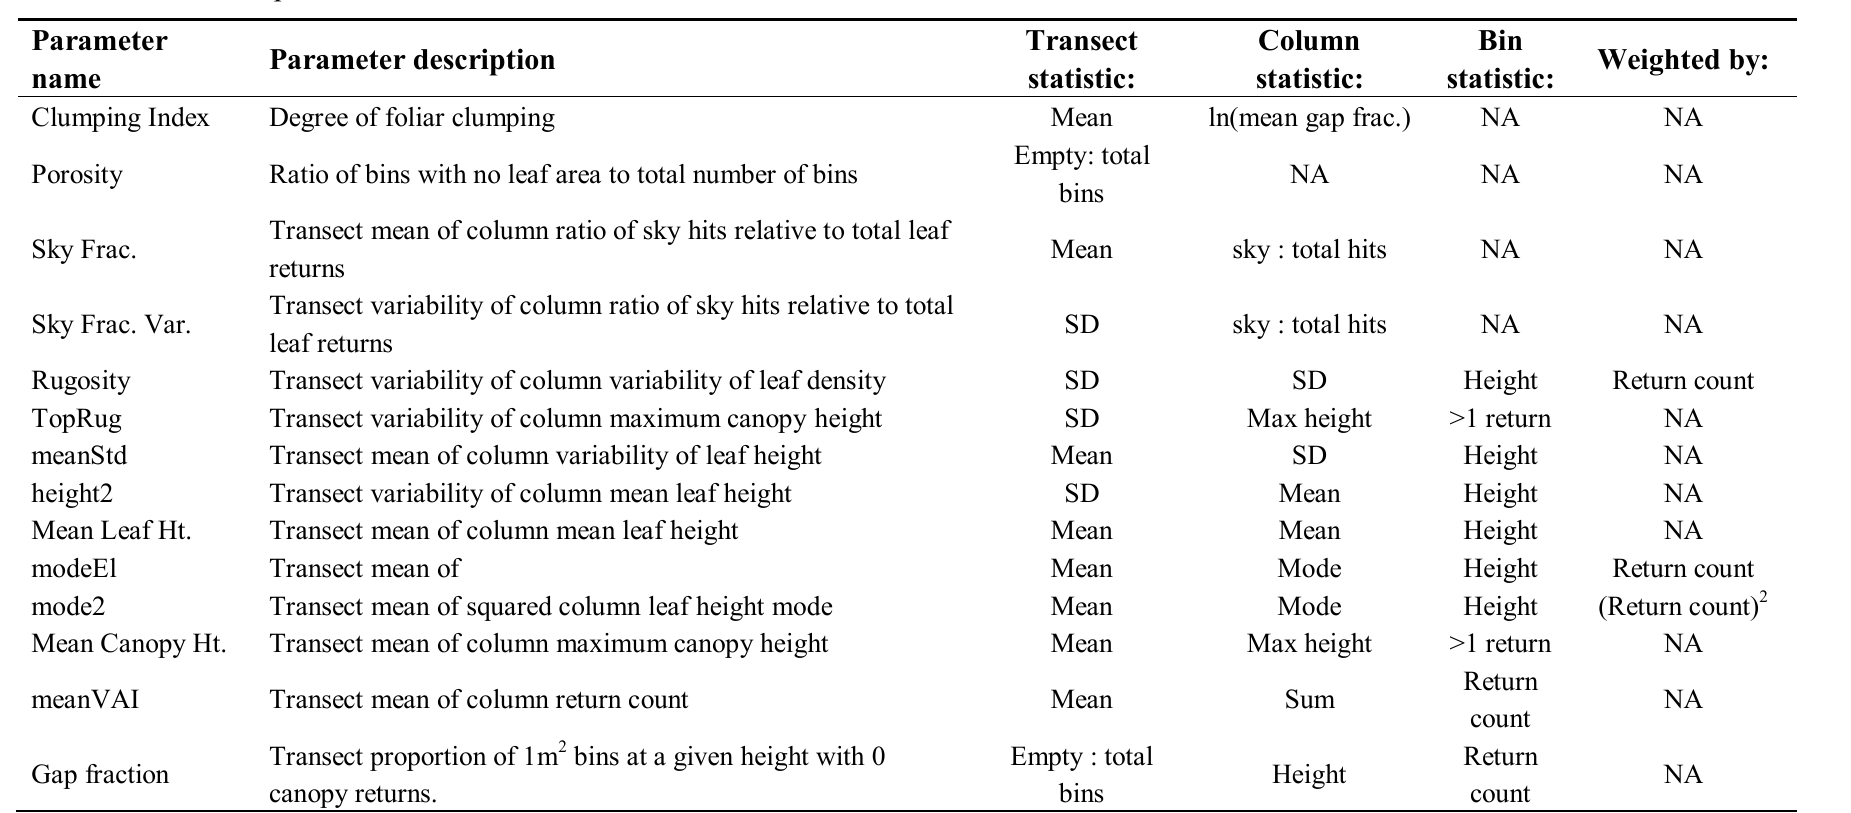
Table 1. Description and method of calculation for 13 metrics of canopy structure derived from PCL data. Parameters were calculated by applying the indicated statistics in the following order: Parameter = transect(column[bin × weight]). For example, modeEl is calculated as the plot mean of the mode of count-weighted return heights in each of 40 columns comprising the transect spanning the plot. “Sky hits” refers to non-returned lidar